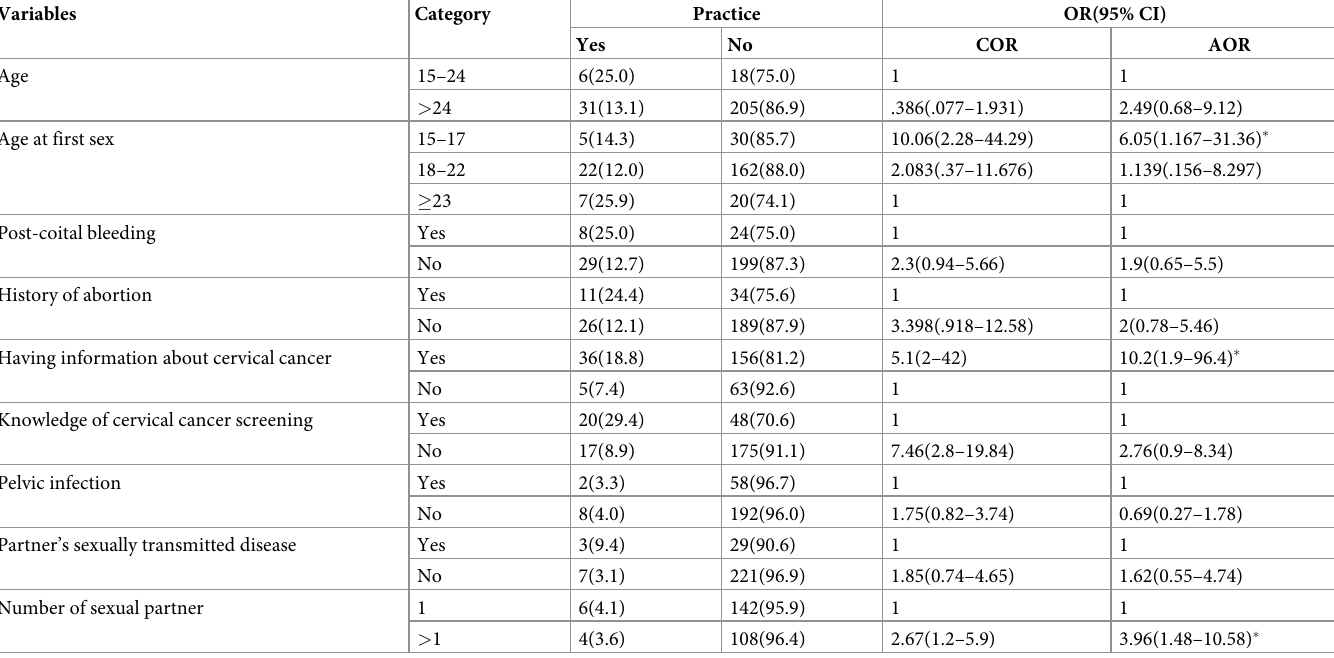
Table 7. Factors affecting the practice of cervical cancer screening among reproductive age group women in districts of Gurage zone, Southern Ethiopia,